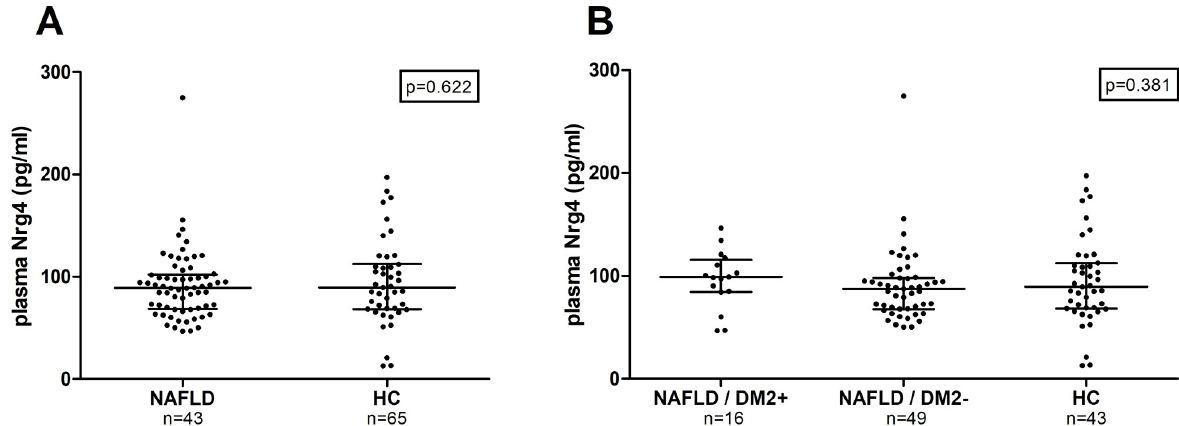
Fig 1. Plasma Nrg4 levels in NAFLD patients versus healthy controls. Values are presented in scatter plots with median line (Q1, Q3). Plasma Nrg4 levels were compared between groups with the Mann-Whitney U-tests (A) and Kruskall Wallis test (B). Plasma Nrg4 levels in (A) HC versus NAFLD patients, (B) NAFLD patients with and without DM2 and HC. DM2, type 2 diabetes mellitus.